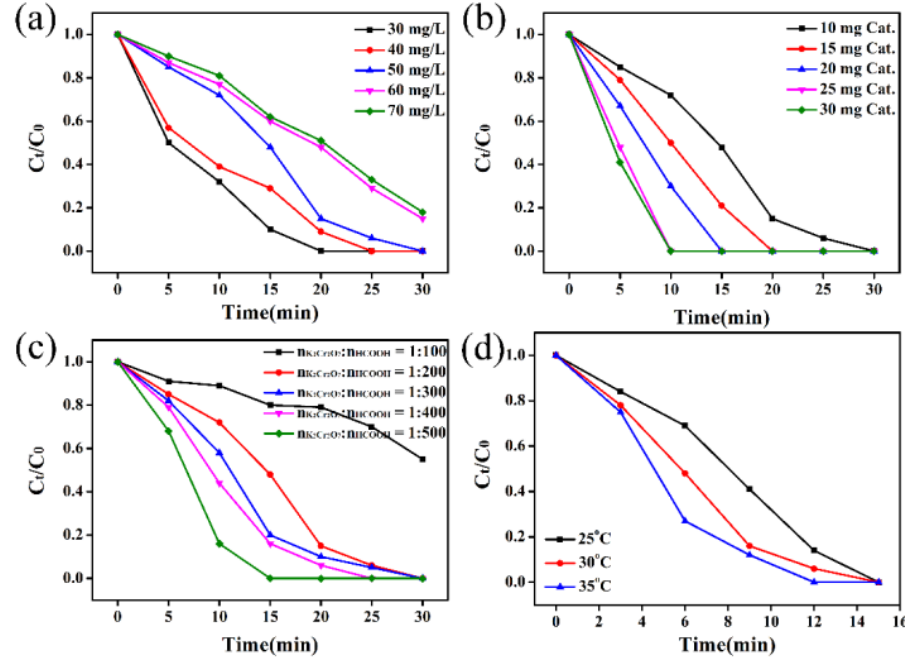
Figure 6. Effects of ( a ) K 2 Cr 2 O 7 initial concentration, ( b ) Pd/TiO 2 amount, ( c ) HCOOH amount (n K2Cr2O7 : n HCOOH ), ( d ) the temperature on Cr (VI) reduction. The temperature-regulated reaction condition: 50 mL, K 2 Cr 2 O 7 50 mg/L; HCOOH 109 µ L; 15 mg Pd/TiO 2 .